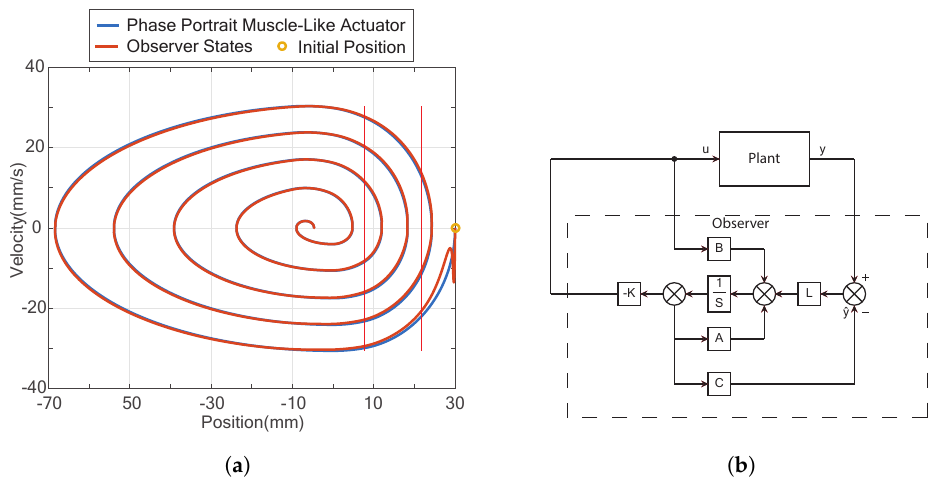
Figure 9. Observer feedback loop and phase portrait: ( a ) phase portrait with observer; and ( b ) observer with full state feedback